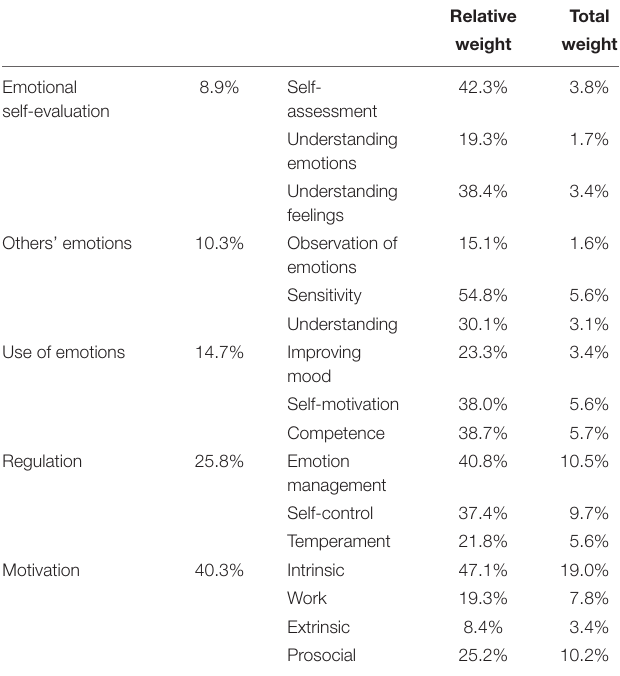
TABLE 1 | Ranking of criteria and subcriteria.